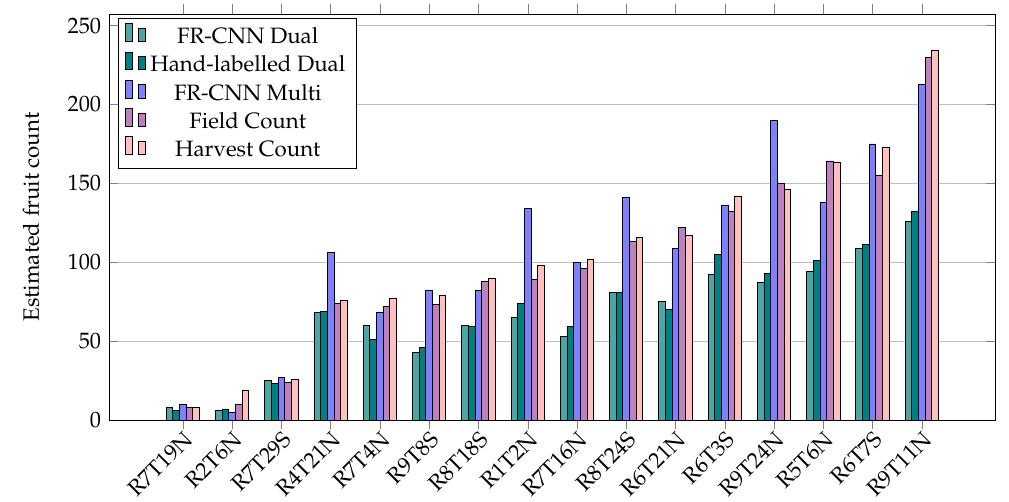
Figure 9. Estimated dual and multi-view counts for 16 target trees, with manual field and harvest ground truth data. FR-CNN and Hand-labelled Dual show the dual-view method using machine and hand labelled detections respectively. FR-CNN Multi refers to the proposed multi-view approach. Field counts were gathered by manually counting the fruit on the tree, in the field, just before harvest. Harvest counts were obtained by manually counting the fruit after removal from the tree. Linear regression models with zero intercept (of the form y = mx ) were fitted between the 359 single, dual and multi-view estimates and the harvest fruit counts, as shown in Figure 10. The 360 single-view method had the lowest precision ( R 2 = 0.81) and lowest accuracy, counting only 27% 361 of the fruit that was actually there. The dual-view method had the highest precision ( R 2 = 0.94) 362 but was also inaccurate, counting 54% of the fruit (double the single-view count). The proposed 363 multi-view approach had high precision ( R 2 = 0.90) and also high accuracy, counting 101.4% of the 364 fruit (a 1.4% over-count). For the dual-view approach, the counting performance was additionally 365 performed using human-labelled images to compare to the FR-CNN fruit detector. 13 There was 366 negligible difference in precision between the hand-labelled ( R 2 = 0.95) and FR-CNN detections 367 ( R 2 = 0.94) but with human labelling, the percentage of detected fruit increased from 54% to 64%, 368 which indicates that the FR-CNN detector missed some fruit in each image. 369